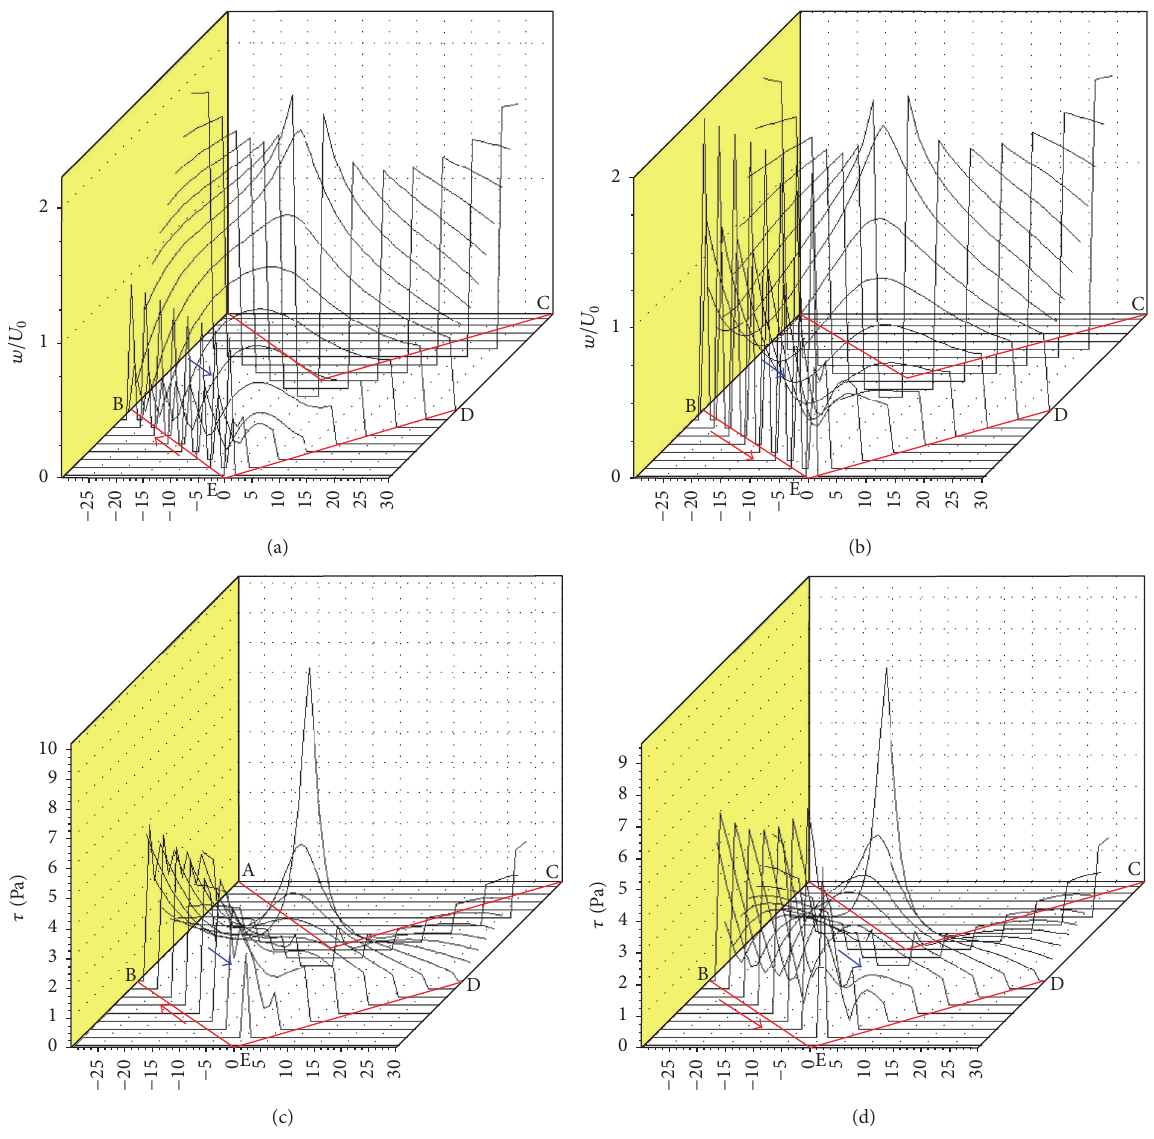
Figure 14: CFD-derived 3D diagrams for dimensionless flow velocity 𝑤 (a, b) and for dimensional tangential stress 𝜏 (c, d) for a Segal die with channel intersection angles ∠ (AOC) = 2 𝜃 = 105 ∘ , where inlet die wall BE moves upstream towards the punching direction with velocity = −𝑈 𝑉 𝑤 0 (a, c), inlet die wall BE moves downstream stream-wise with increased velocity dimensional transition times are 1.258 s (a, c) and 1.797 s (b, d).